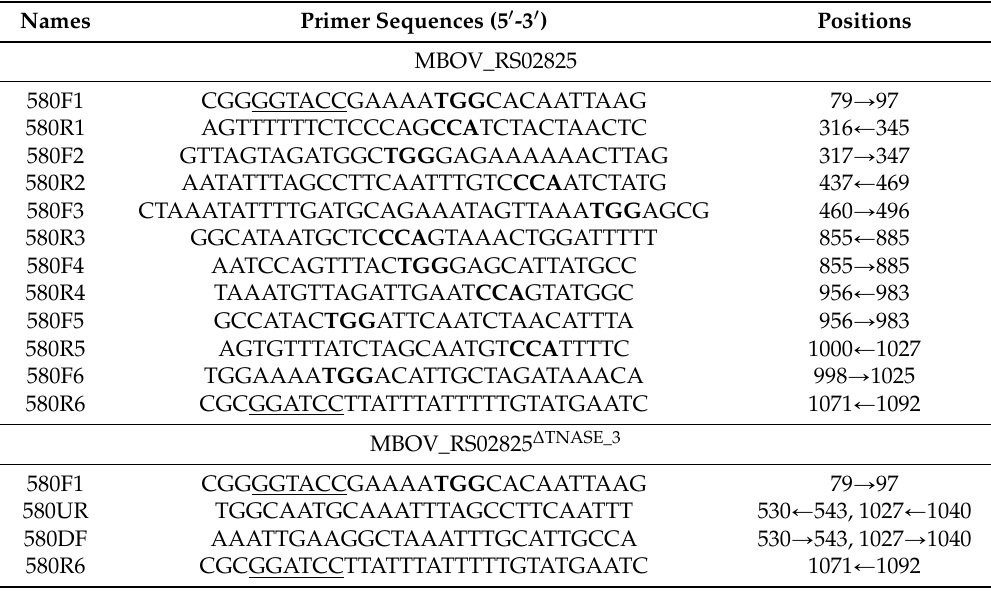
Table 1. Oligonucleotide primers for PCR used in this